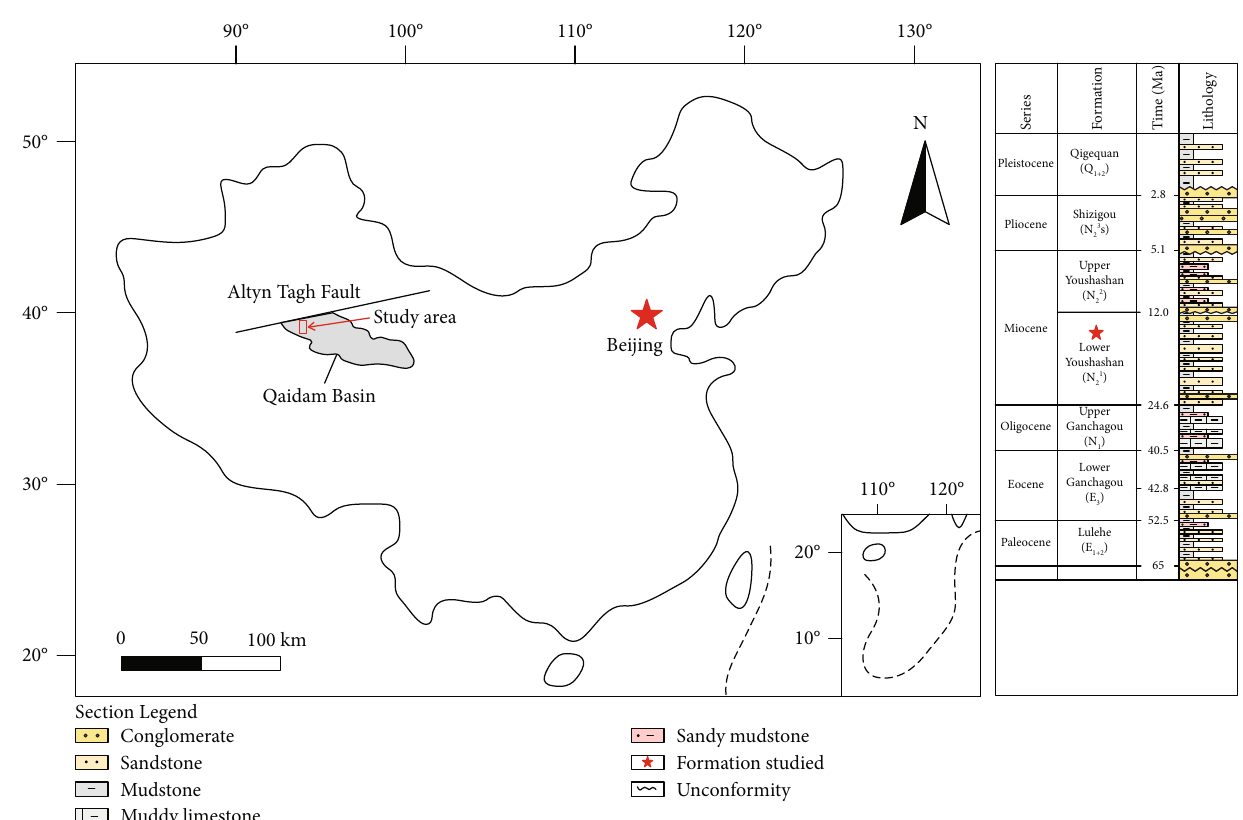
Figure 1: Location and lithological and stratigraphic system of the study area (modi fi ed from